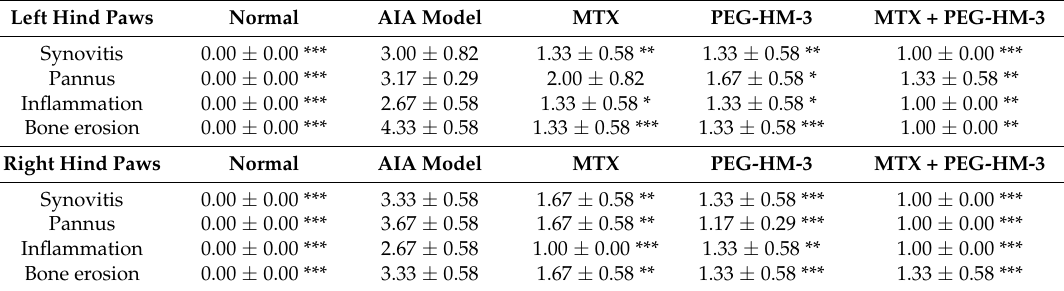
Table 1. Histological inflammation score in the joint cavity in arthritis